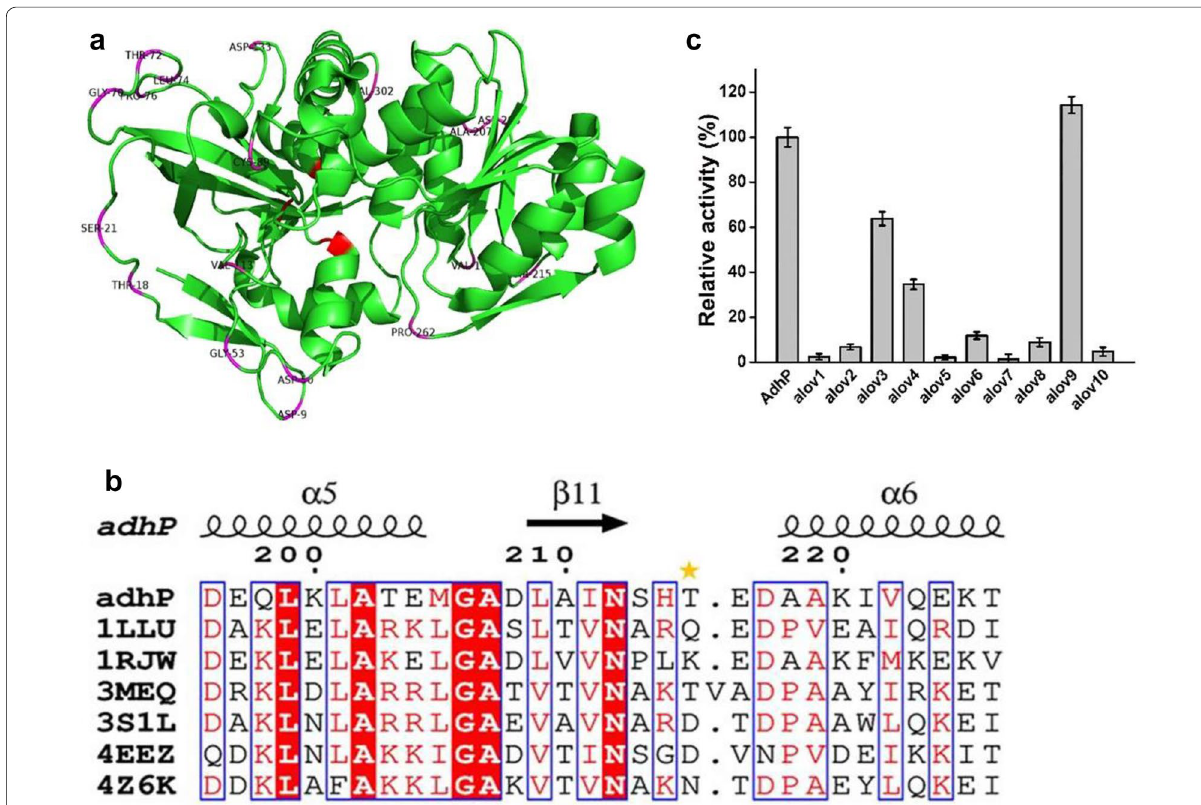
Fig. 1 Designing alovX (X present different insertion sites) photoswitches. a Crystal structure analysis of wild-type AdhP protein to select surface-exposed loop (red represents active center of AdhP. Magenta represents exposed sits in surface loop). b Screening unconservative sites from surface-exposed loops by sequence alignment (yellow star represents the selected site. The information of ten sites at Additional file 1: Figure S3). c Comparing catalytic activity between WT AdhP and alov1-10 fusions in the dark state. Error bars show SEM ( n